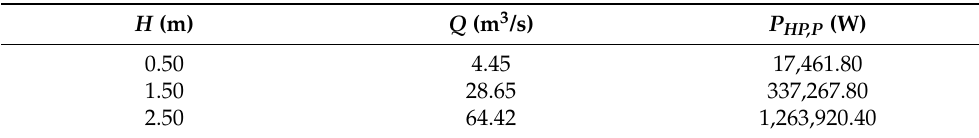
Table 2. Insight into the potential power of the turbines with respect of the potential hydro energy for the Bednja River.